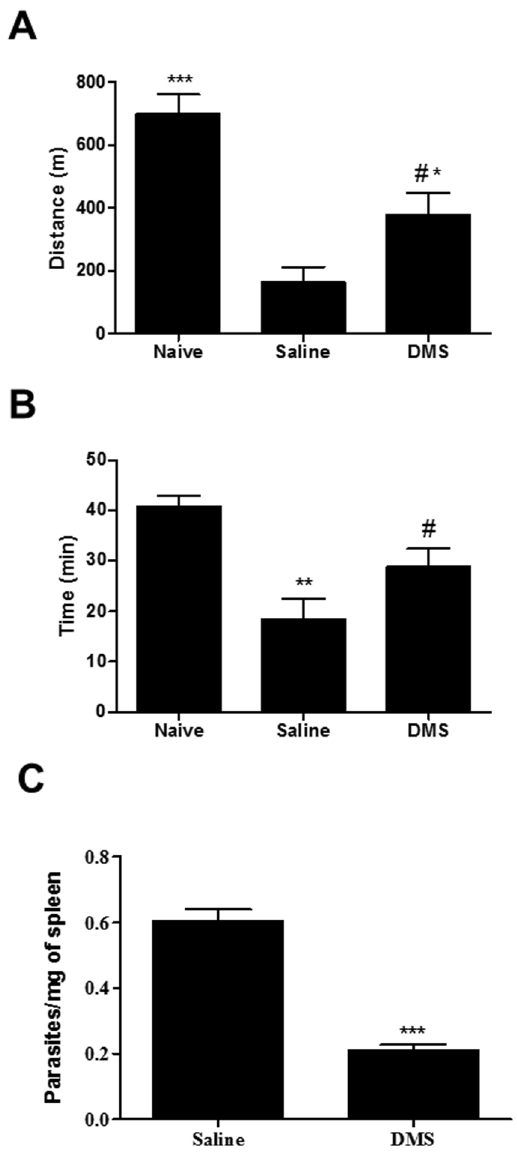
Figure 4. Effects of DMS treatment in cardiac function and parasite load. After an adaptation period in the treadmill chamber, naive and saline-treated or DMS-treated chronic Chagasic mice exercised at 5 different velocities (7.2, 14.4, 21.6, 28.8 and 36.0 m/min), with increasing velocity after 5 min of exercise at a given speed. ( A ) Distance run and ( B ) Time of exercise on a motorized treadmill. ( C ) Spleen fragments obtained from normal and T. cruzi -infected mice treated with saline or DMS were used for DNA extraction and qRT- PCR analysis for quantification of parasite load (primer 1 5 ′ -GTTCACACACTGGACACCAA-3 ′ and primer 2 5 ′ -TCGAAAACGATCAGCCGAST-3 ′ ). The standard curve of DNA ranged from 4.7 × 10 − 1 to 4.7 × 10 6 ). Bars represent means ± SEM of 8–10 mice/group. *** P < 0.001; ** P < 0.01; * P < 0.05 compared to saline group; # P < 0.05 compared to naive